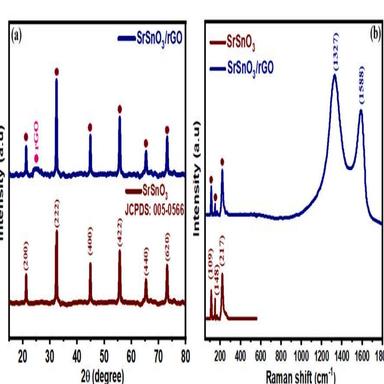
(a) XRD of SrSnO3 and SrSnO3/rGO nanohybrid and (b) Raman spectrum of SrSnO3 and SrSnO3/rGO nanohybrid.